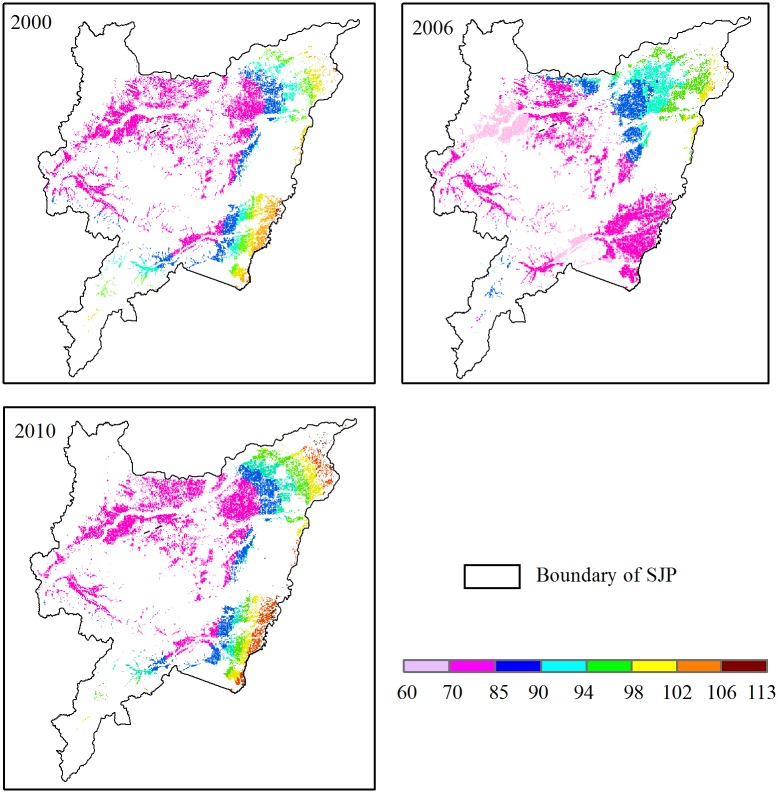
Spatial distribution of precipitation (P: mm month-1) in 2000, 2006 and 2010.